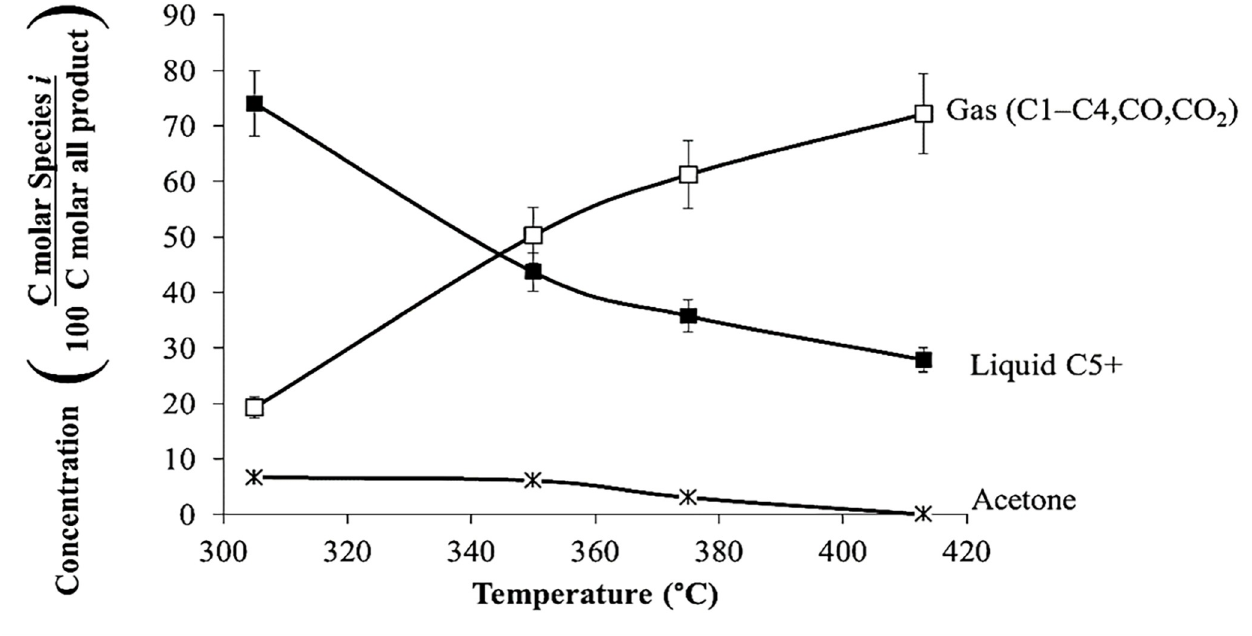
Fig 6. Product distribution of gases and liquids for the acetone reaction over HZSM-5(80), WHSV = 1.3 h –1 , and P = 101 kPa (abs).